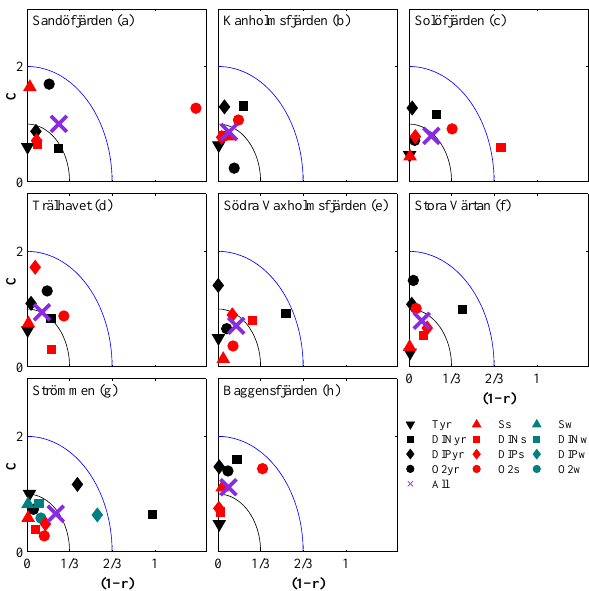
Figure 6. Average cost function ( C ) and correlation coefficients, adjusted (1 − r ) to the range 0–1, for an overview of the model skill at the eight different validation sites (a–g) . The individual skills of the different parameters, average seasonal variation (black) and/or the vertical summer (red) and winter (turquoise) profiles of temper- ature ( T ), DIN, DIP and oxygen concentrations (O 2 ) are shown, as well as the combined model skills for all variables (purple cross). Variables within the inner quarter circle and between the two quar- ter circles are considered to be good and acceptable, respectively, while variables that are outside the quarter circles are not well sim- ulated.